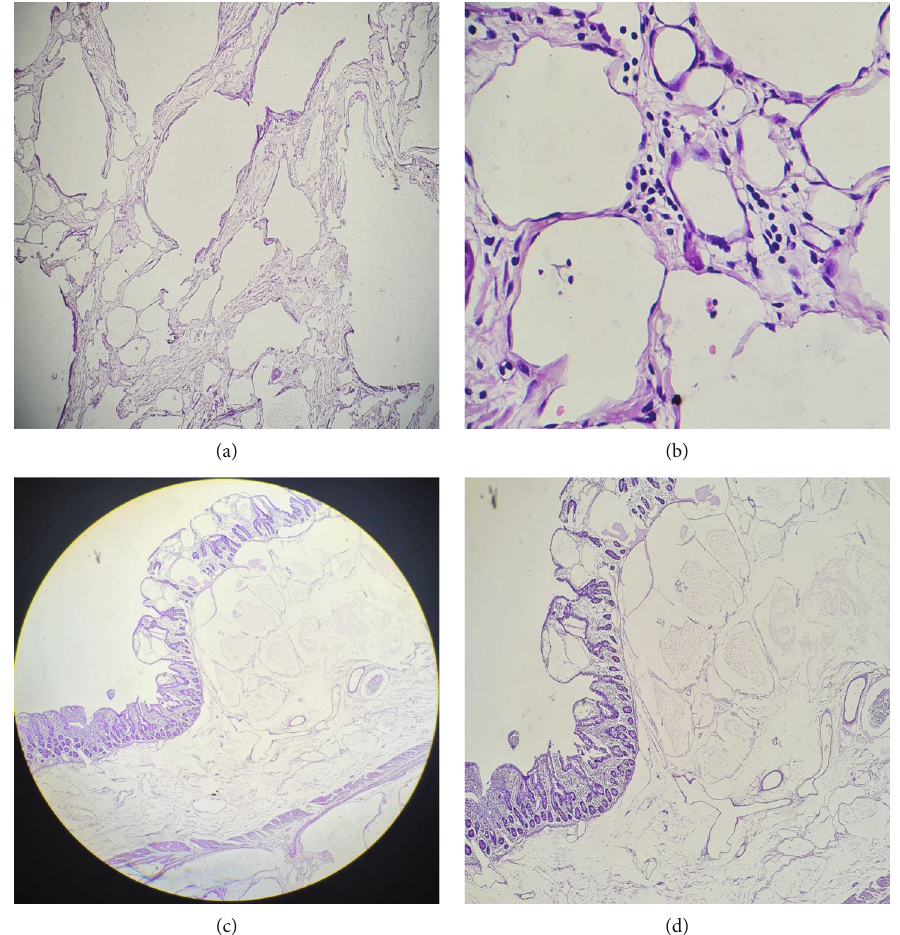
Figure 3: (a) Photomicrograph of mesenteric lymphangioma showing numerous cystically lymphatic channels (hematoxylin & eosin stain, 4x); (b) lined by fl attened endothelium and perivascular lymphoid in fi ltration; (hematoxylin & eosin stain, 40x); (c, d) involvement of mucosa, submucosa, and muscularis propria by lymphangioma (hematoxylin & eosin, 4x and